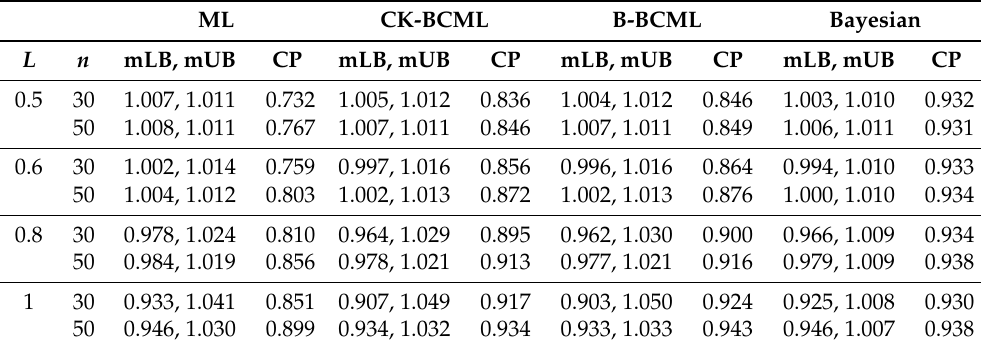
Table 5. The mLBs, mUBs and CPs for the 95% ACI and HDPI when µ = 10 and λ =